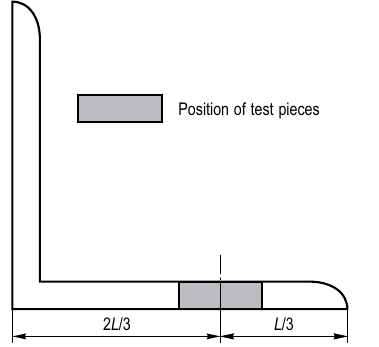
Fig. 1. Structural steel section, position and orientation of sample (IS 2062:2006 )